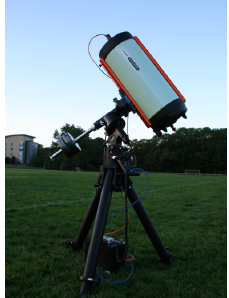
Figure 1. OSCOM telescope system for small satellite and debris photometry deployed in Needham, MA, USA. Used with permission from Gasdia et al. [14] c (cid:13) 2016 AMOS